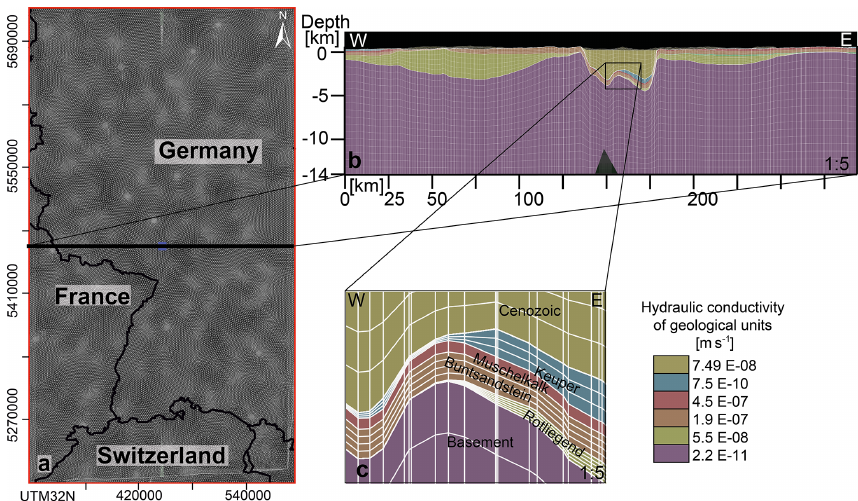
Figure 3. Numerical mesh illustrated as white lines: (a) from above, (b) as a cross section with 5 times vertical exaggeration, and (c) as a